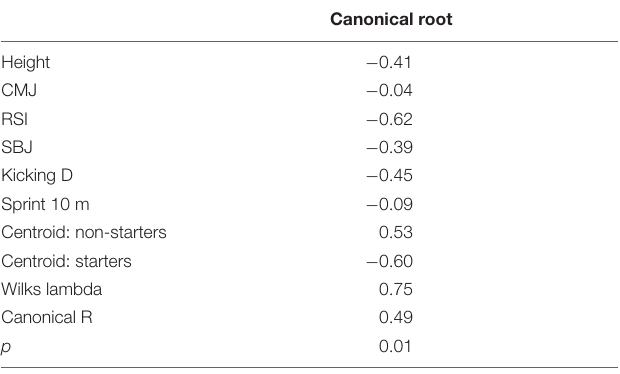
TABLE 3 | Multivariate differences between starters and non-starters in studied variables (forward stepwise discriminant canonical